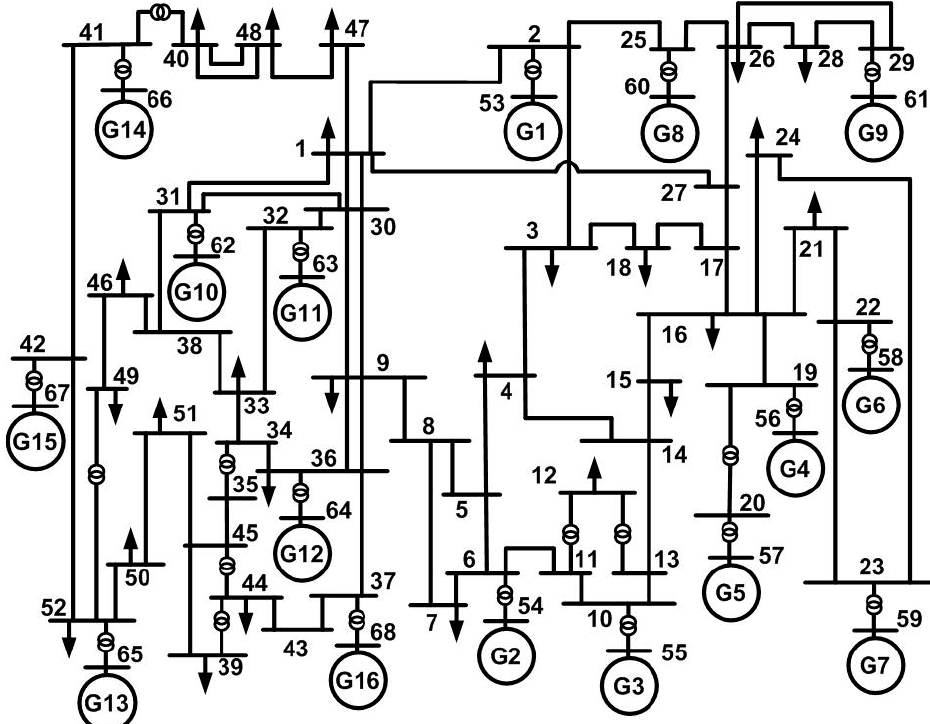
Figure 12. Single line diagram of IEEE 16-machine 68-bus system [24].